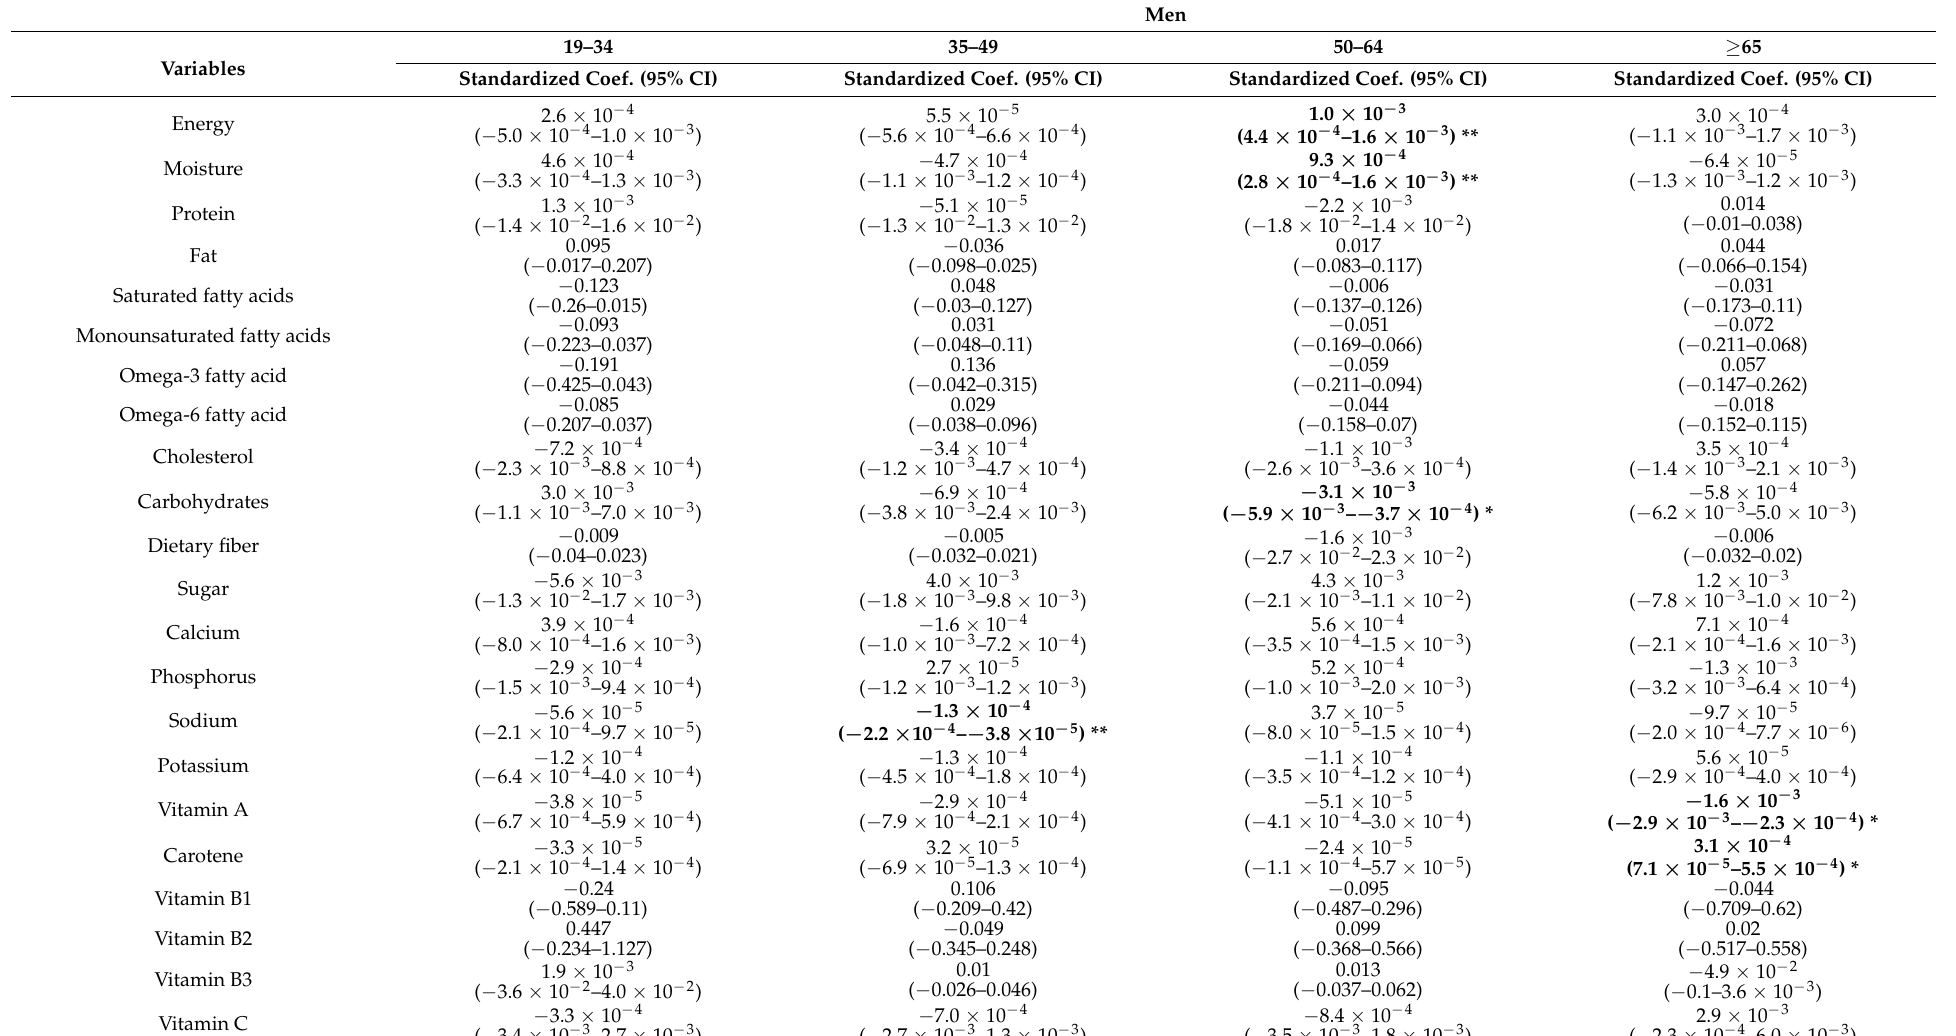
Table 3. Multiple linear regression results for the men’s